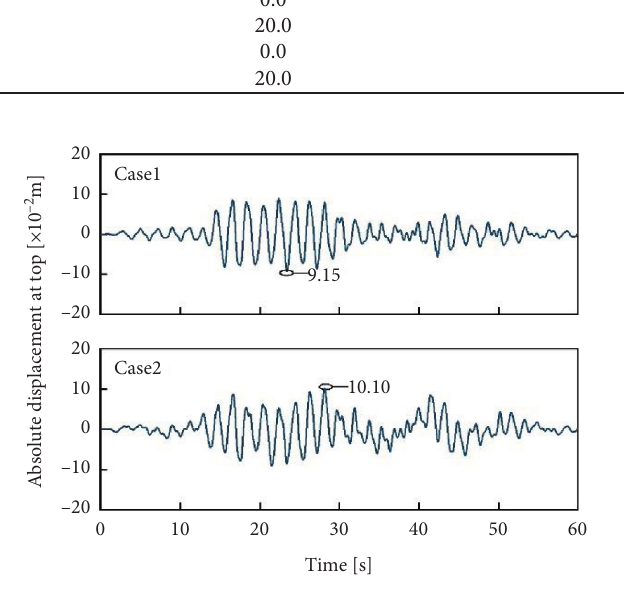
Figure 5: Absolute displacement time histories of pier No. 4 in Cases 1 and 2. Table 3: Fundamental periods and the elongation ratios.